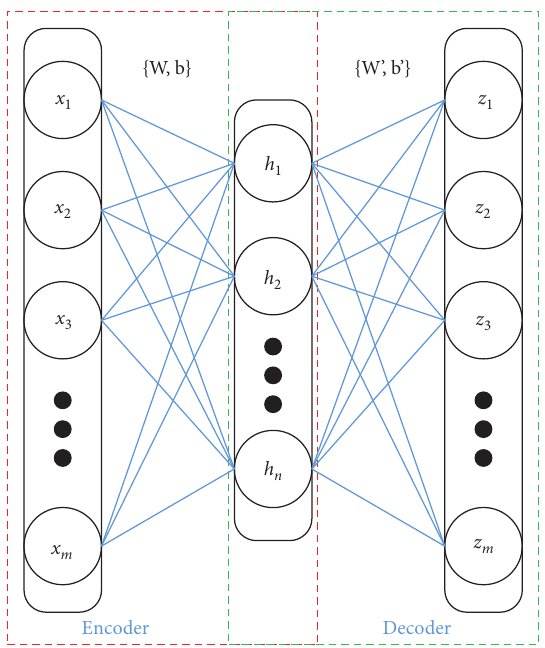
Figure 1: The structure of an